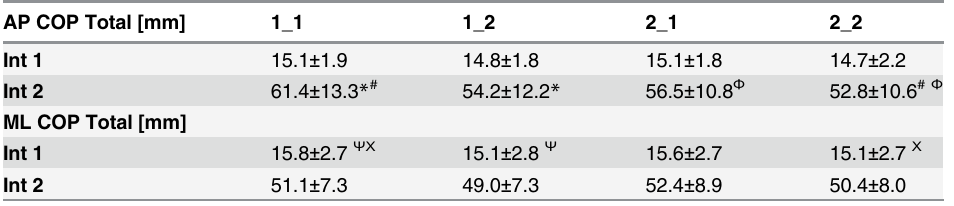
Table 1. COP Total excursions (mean ± SD) for both perturbation directions (AP, ML), all four measure- ment sessions and all analyzed intervals. Significant differences between the four measurement sessions are marked with superscripted symbols; see below ( α = 0.0125).